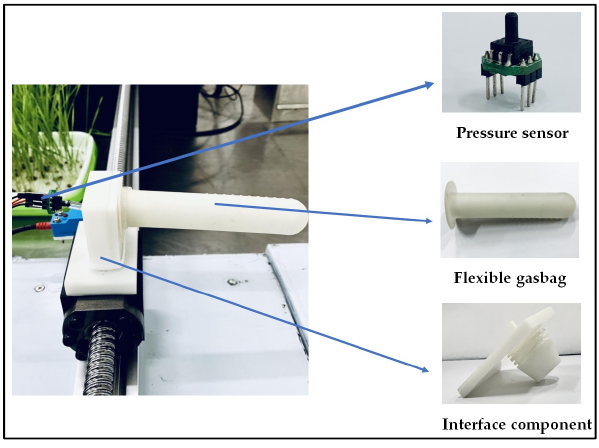
Figure 1. Diagram of rice plant recognition sensor.